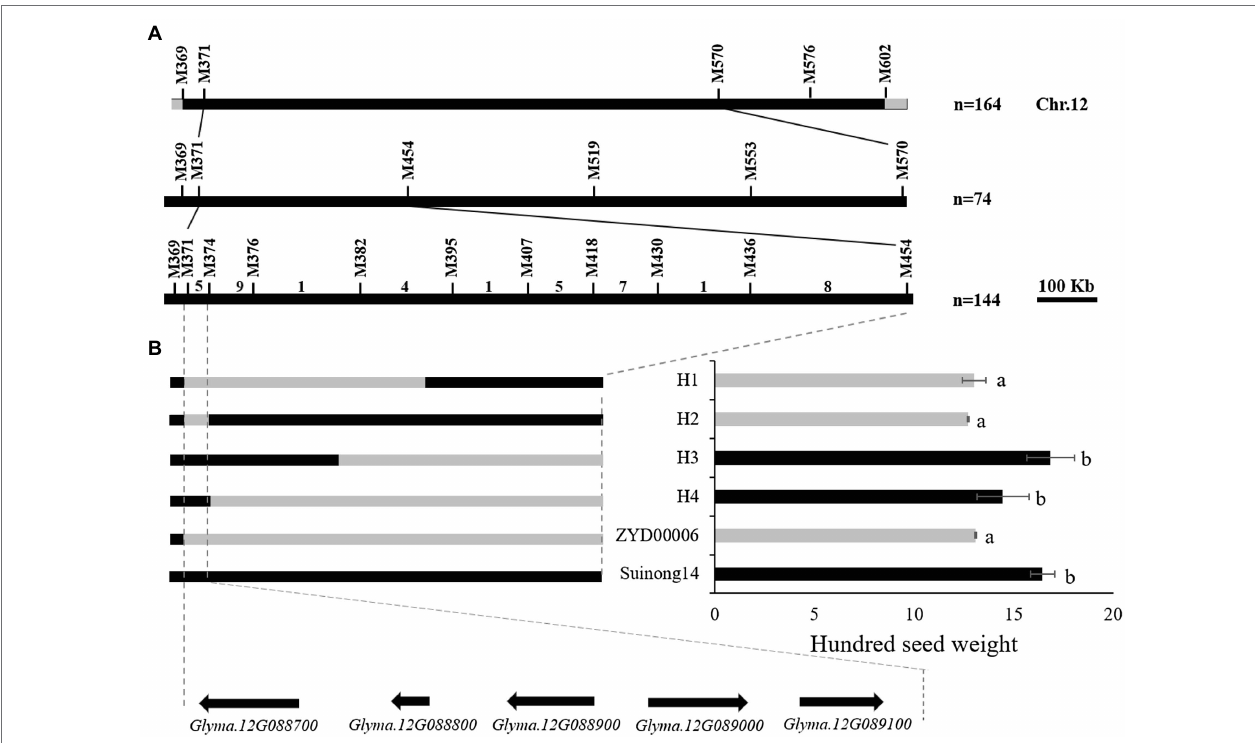
FIGURE 6 | QTL fine mapping. (A) The qHSW-12-3 locus was detected on chromosome 12. Positional mapping narrowed the qHSW-12-3 locus to a 64.4 kb region between M371 and M374. The numbers above the bars indicated the number of recombinants. (B) Fine-map the genotype of the population and the significance of the corresponding phenotype. Gray indicates Suinong14 genotype, black indicates ZYD00006 genotype. a, b: Different letters represent significant differences between each other at the 0.01